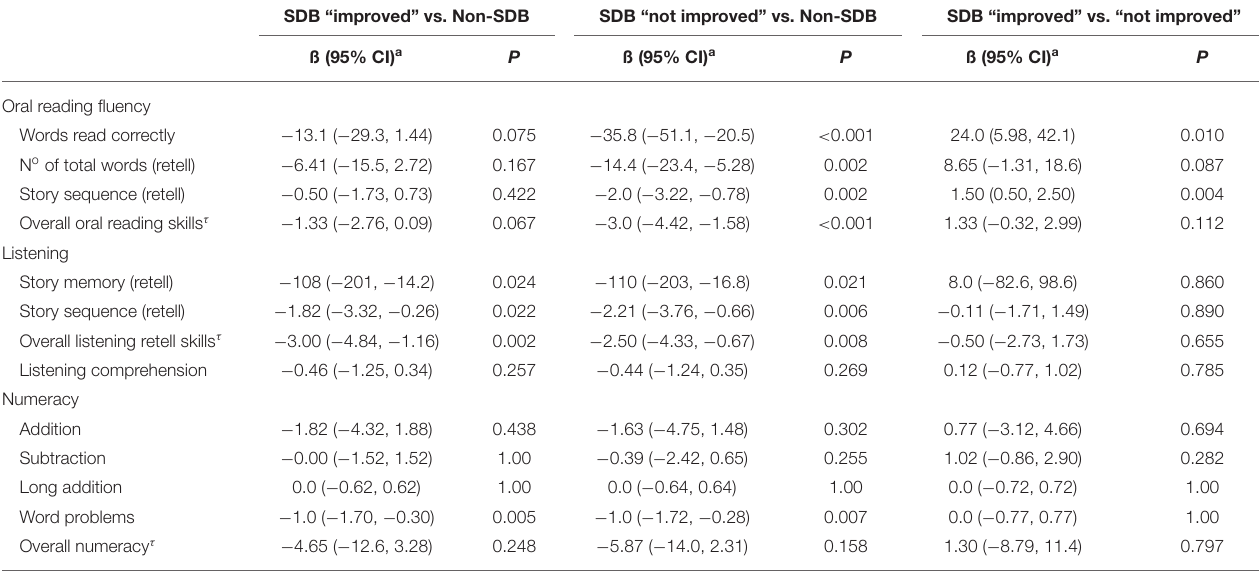
TABLE 5 | Unstandardized regression coefficients (ß) representing mean differences in academic outcomes at age 8 between sleep disordered breathing (SDB) trajectory groups and non-SDB